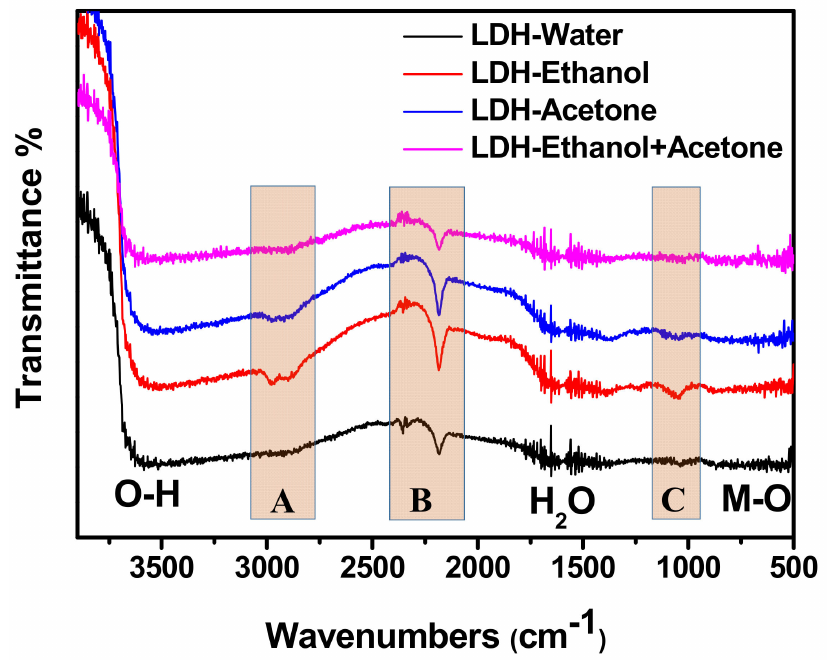
Figure 2. FTIR spectra for NiCoAl-Water, NiCoAl-Ethanol, NiCoAl-Acetone, and NiCoAl- Ethanol +